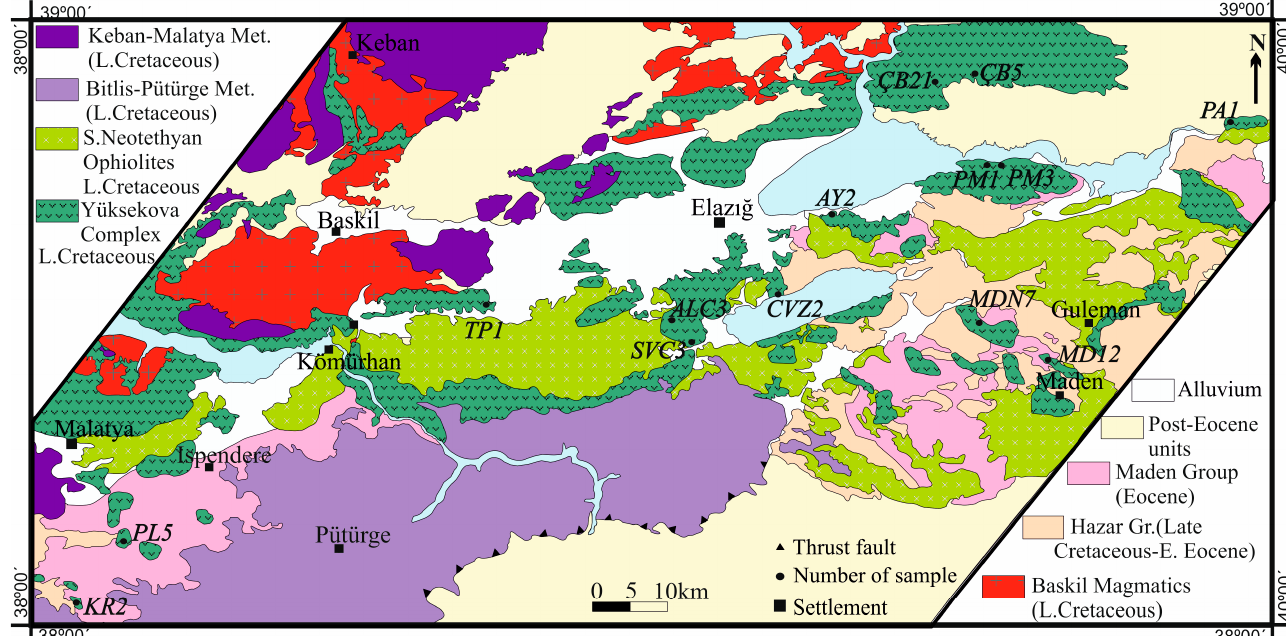
Figure 2. Geological map of the Elaz ı ğ region together with the locations of the studied samples in this study (modified after [12,13]).